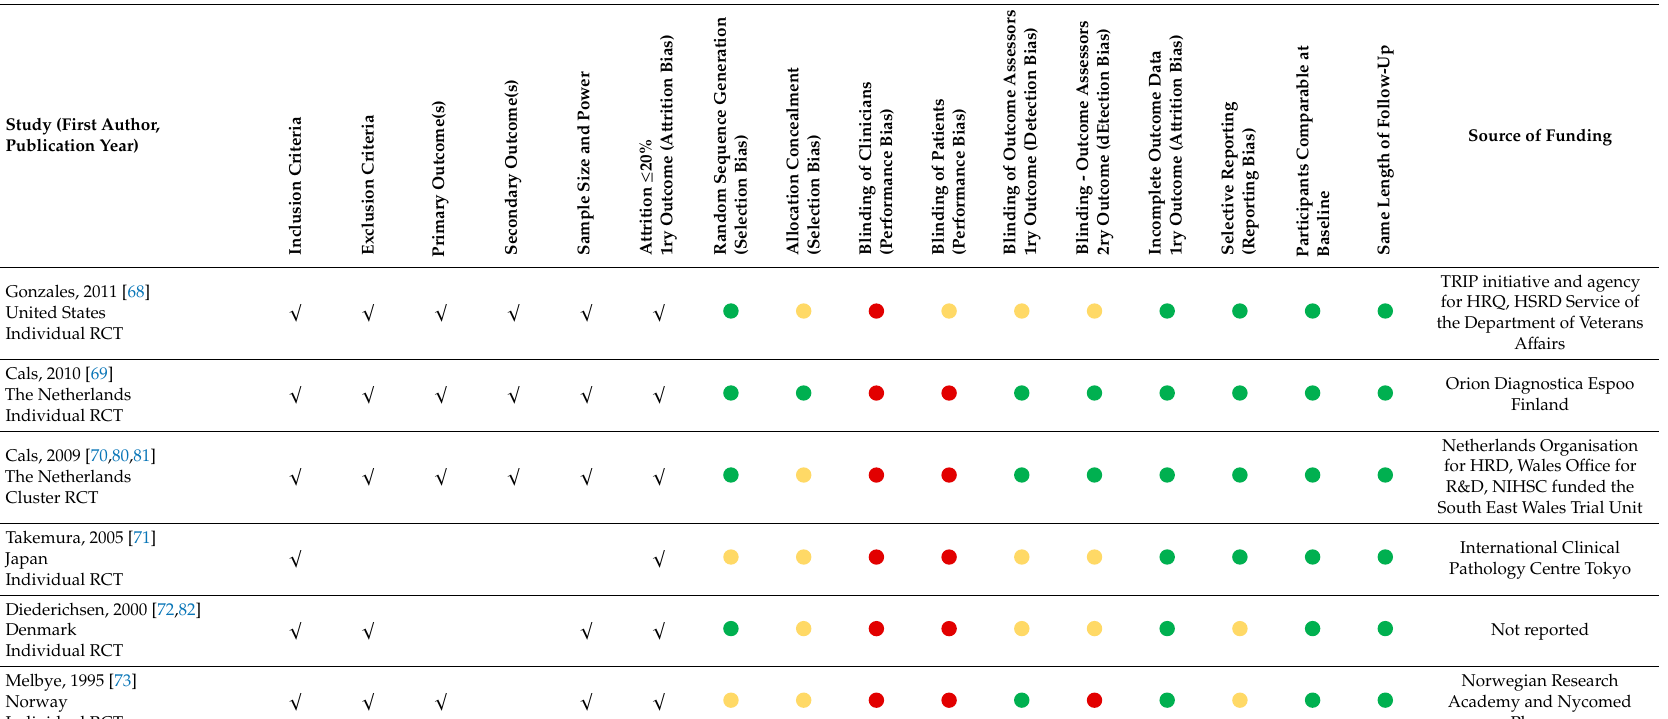
Table 2. Cont. Table 2. Methodological features and risk of bias in the included studies. Table 2. Methodological features and risk of bias in the included studies. Table 2. Methodological features and risk of bias in the included studies. Table 2. Methodological features and risk of bias in the included studies. Table 2. Methodological features and risk of bias in the included studies. Table 2. Methodological features and risk of bias in the included studies.